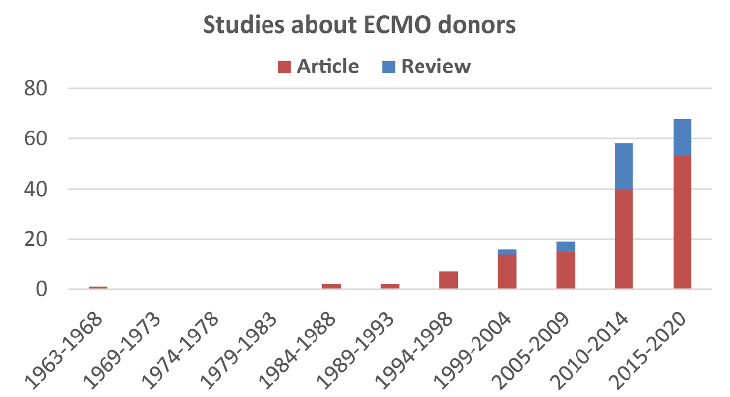
Figure 5. Studies about ECMO donors published from 1963 to 2020.